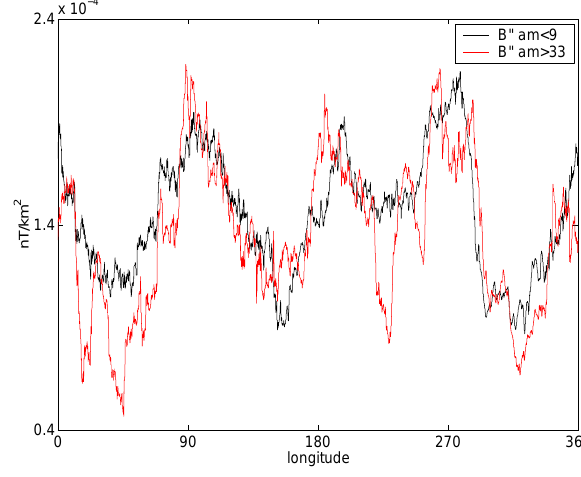
Fig. 10. Variation with geomagnetic activity of the longitude profile of the equatorial electrojet field, longitudinal component, in nT/km 2 : am < 9 (in black), am > 33 (in red).